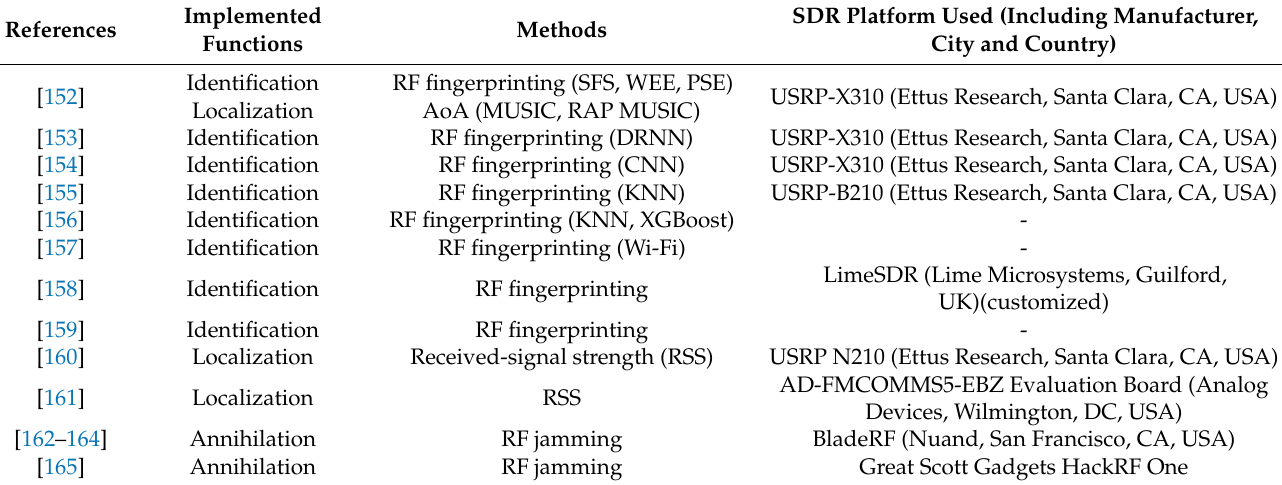
Table 7. RF-based drone detection and defense